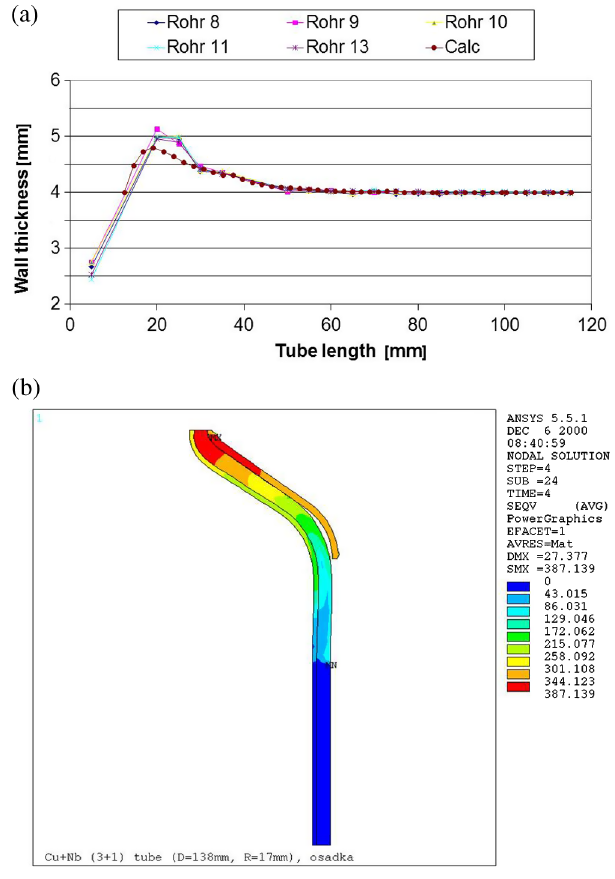
FIG. 4. (a) Comparison of FEM simulated wall thicknesses T after necking with experimental data (Tubes 8 – 9,11,13). (b) Calculated stress distribution after